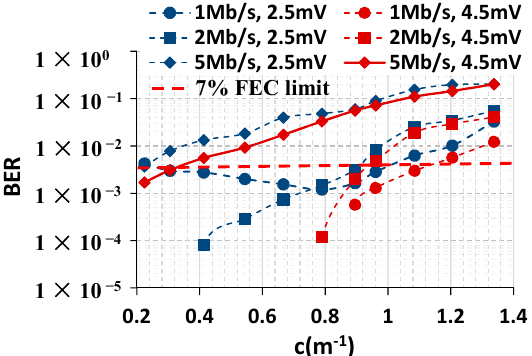
Figure 8. Experimental BER performance under different water turbidities after 10 m.